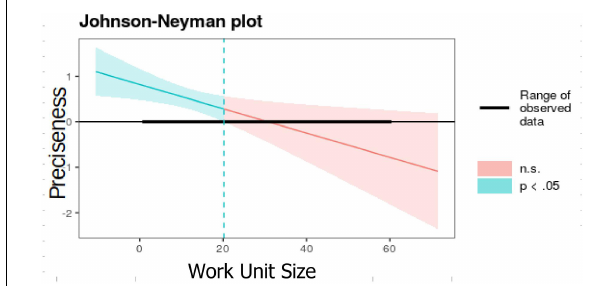
FIGURE 2 | The moderating effect of WUS on the relationship between preciseness and LMX.